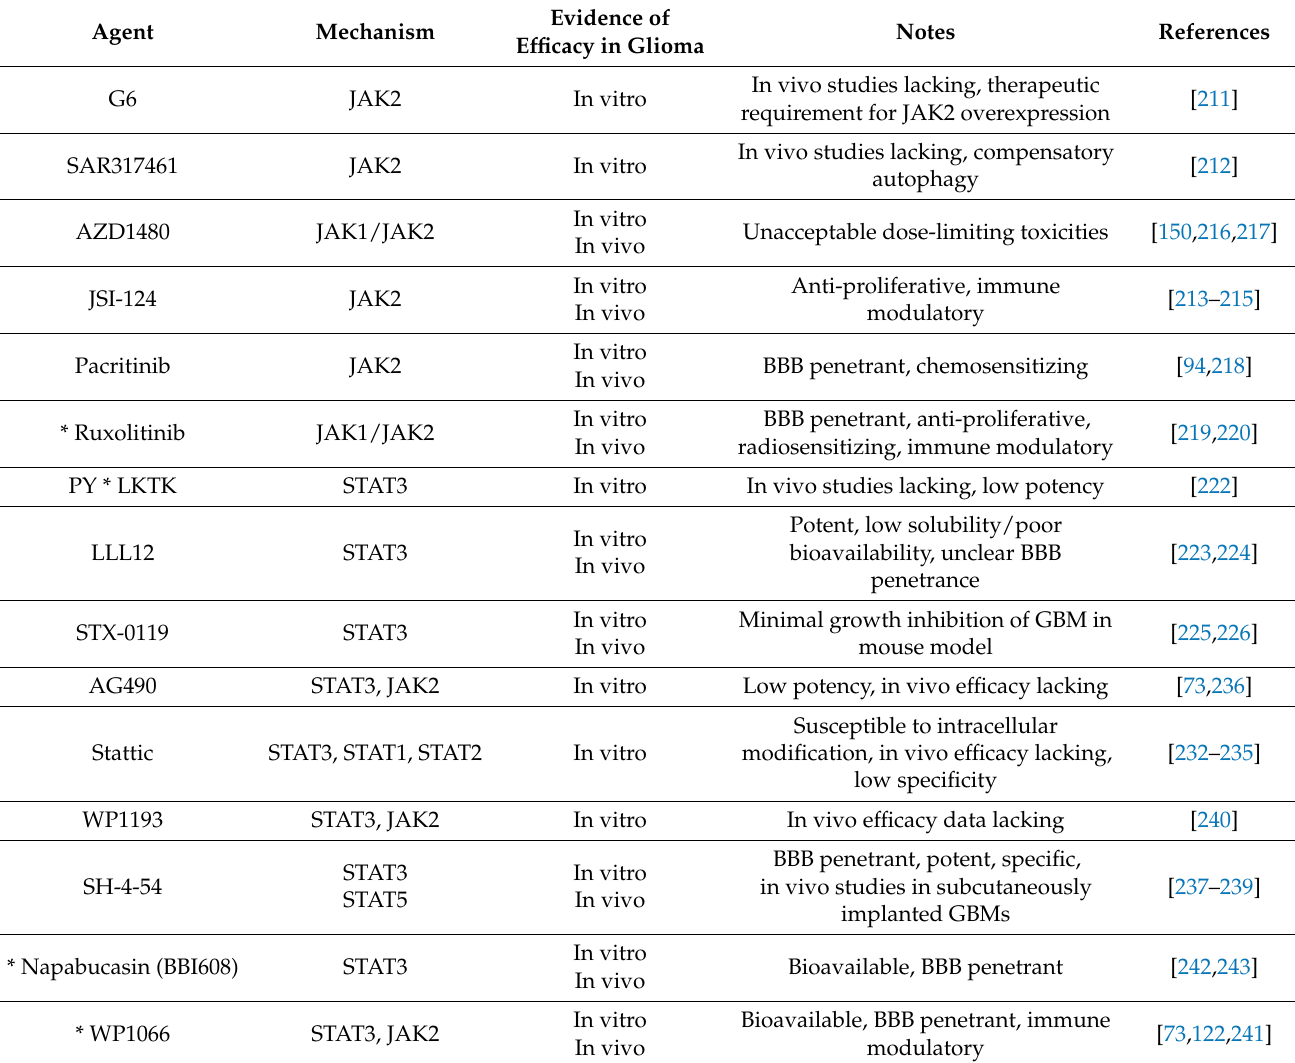
Table 2. Pharmacologic inhibitors of STAT3 signaling investigated in